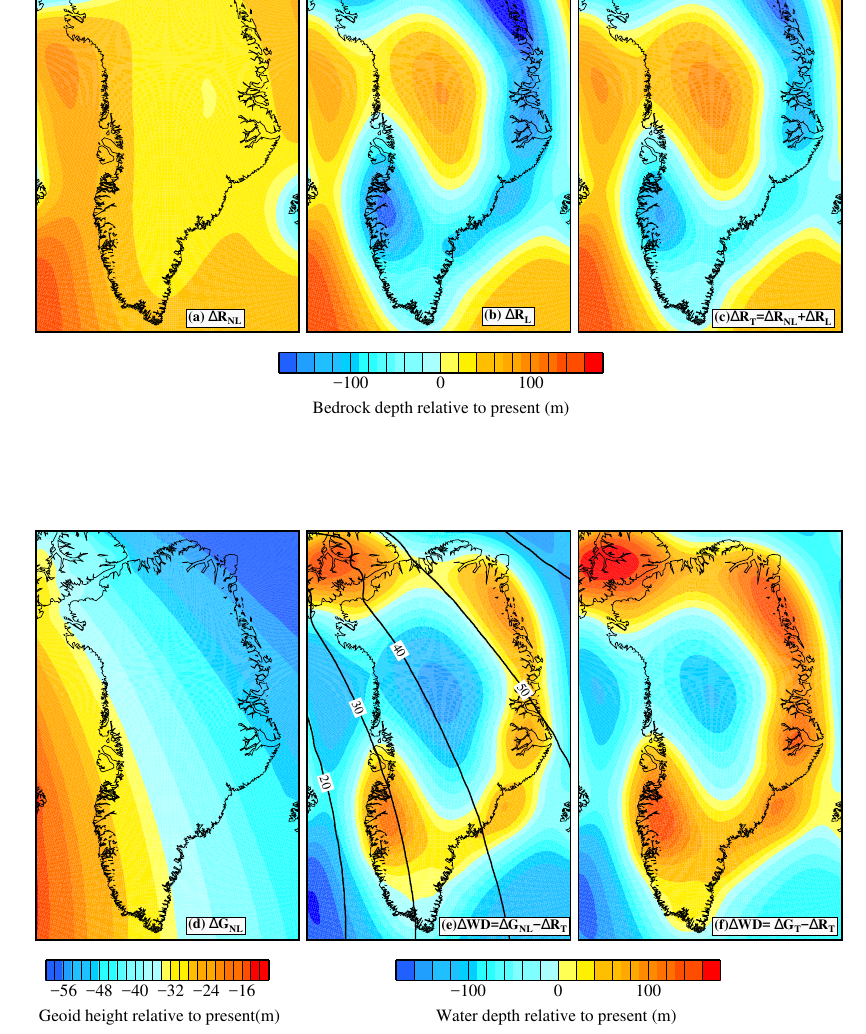
Referring back to Eq. (5), using this method results in the following revised equation for (cid:49)W D